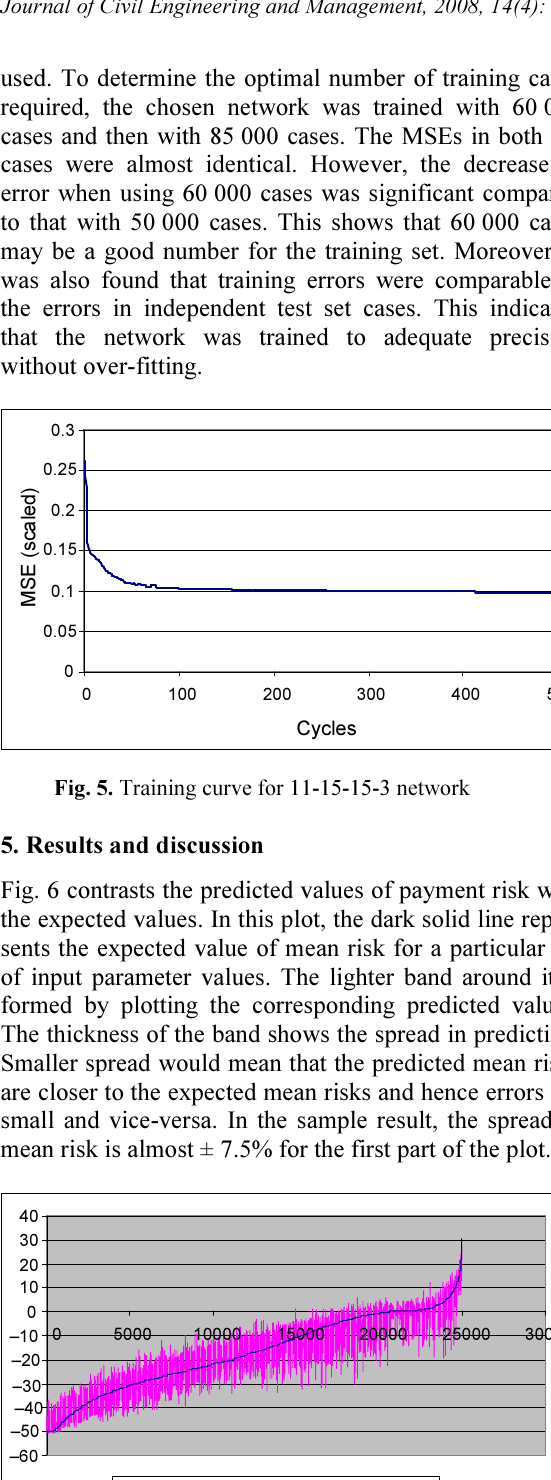
Fig. 6. Expected versus NN predicted mean risk magnitude Figs 7 and 8 show the results for two standard risk plots for air voids in constructed asphalt pavements. The entire plot is obtained by running the neural network simulation for each data point. Fig. 7 shows that for the cases analyzed the predicted values are very close to the expected values. If the network does predict risk with this